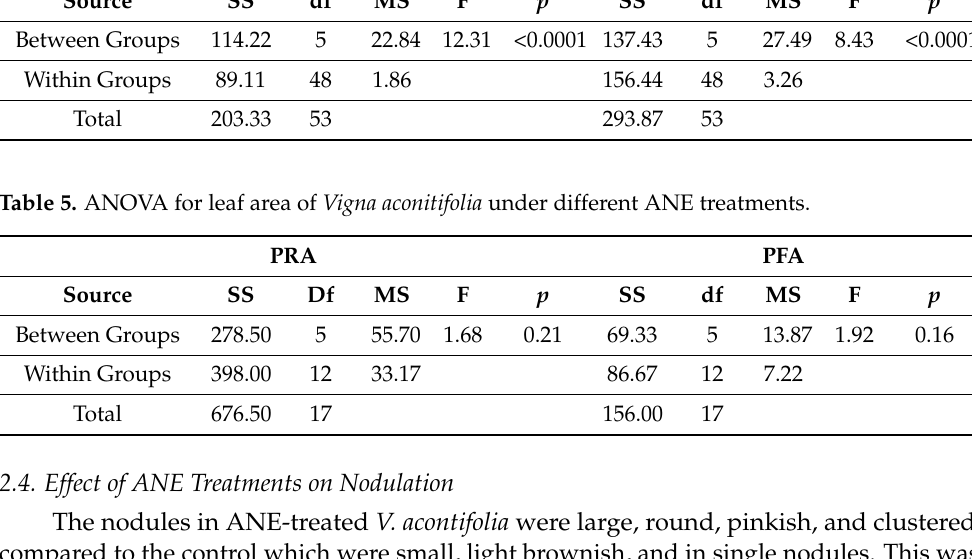
Table 4. ANOVA for number of leaves of V. aconitifolia on 30th day. PRA PFA Source SS